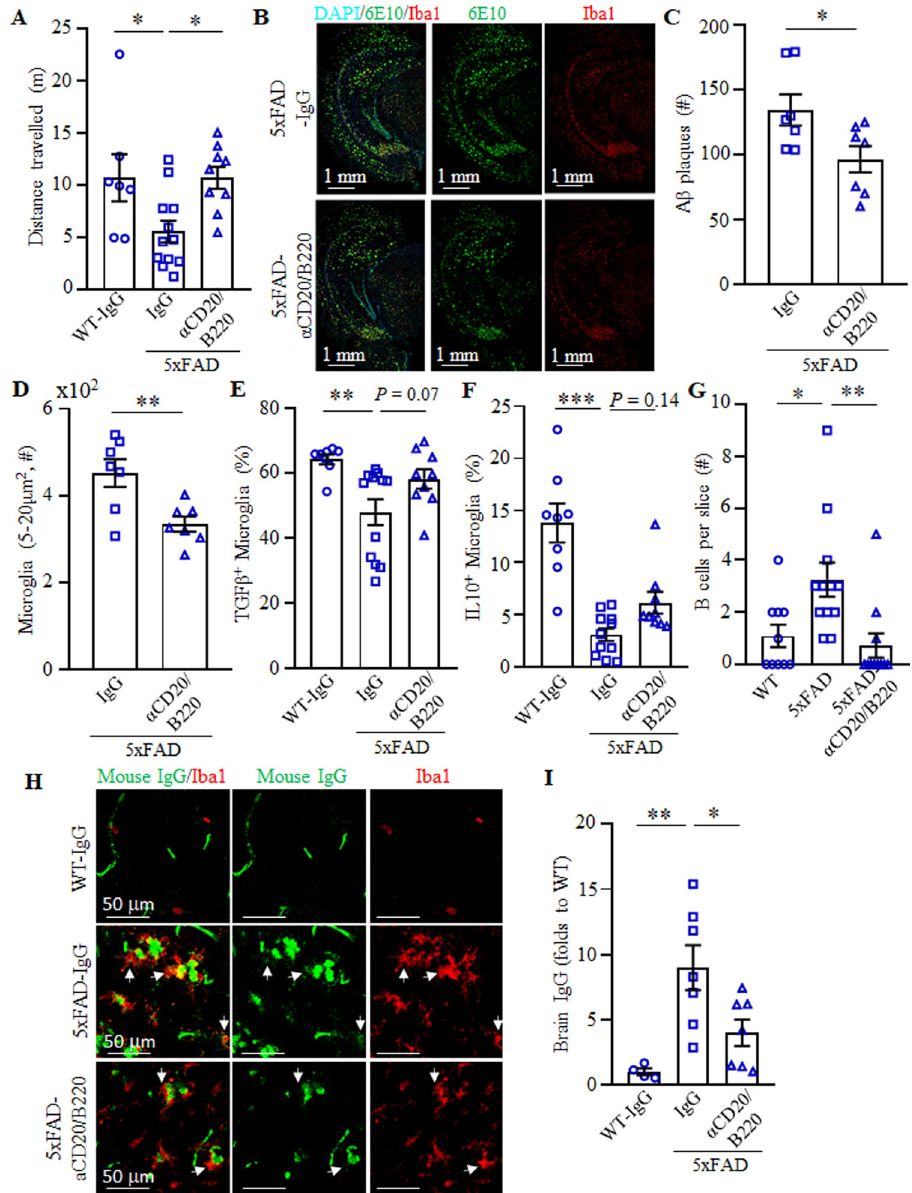
Fig. 5 Therapeutic depletion of B cells improves AD symptoms in 5×FAD mice. OFA test revealed that B-cell depletion improves the retarded locomotion of 5×FAD mice ( A , total distance travelled in fi rst 5 min). B-cell depletion reduced A β plaque burden in the hippocampus ( B , C ). Representative immune fl uorescent staining images for A β plaques (green), Iba1 + microglia (red), and DAPI (cyan) are shown in B . In C and D , the results of quanti fi cation of A β plaques and microglia are shown ( D , large size, 5 – 20 μ m 2 ), respectively. A – D Results were reproduced twice, n = 7 – 12. Flow cytometric evaluation of brain microglia (CD11b + CD45 int ) revealed that B-cell depletion increases the frequency (%) of TGF β + ( E ) and IL10 + ( F ) microglia in 5×FAD mice ( n = 10 – 12). As shown with immune fl uorescent staining, B220 + B cells were markedly increased in the brain parenchyma of 5×FAD compared with WT controls, which was lost after transient B-cell depletion ( G , n = 9 – 12). The brains of 5×FAD mice contained high levels of IgG as compared with WT controls, which was also reversed by transient depletion of B cells ( H and I ). In H , IgG is green and Iba1 + microglia is red. Brain IgG quanti fi cation is in I ( n = 5 – 7). Mean± SEM is shown; each symbol is for a single mouse. Gating strategy is shown in Supplementary Fig. 9B. * p < 0.05; ** p < 0.01; *** p < 0.001 in one-way